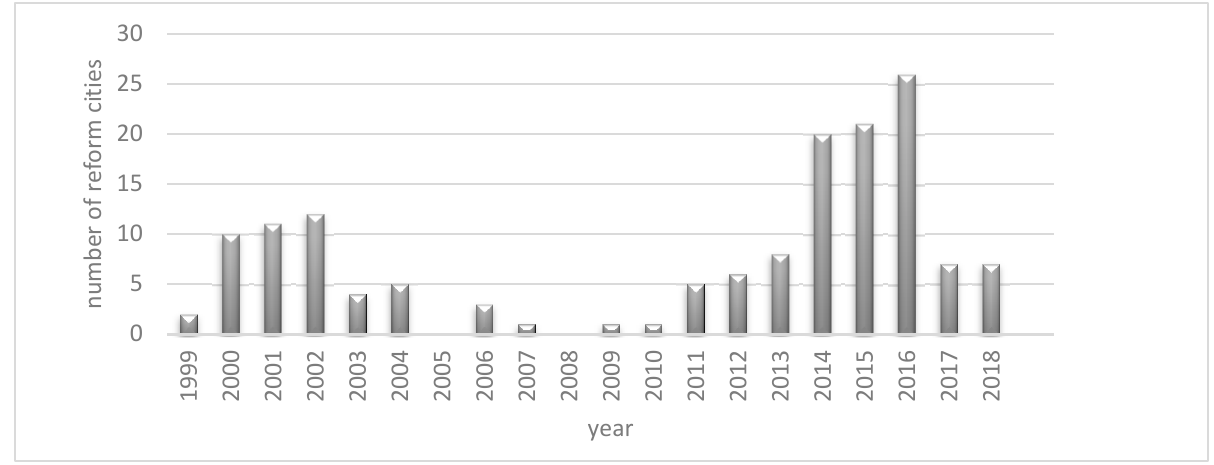
Figure 1. Number of county-to-district reforms in China, 1999–2018. Data source: Calculated based on all reform documents.